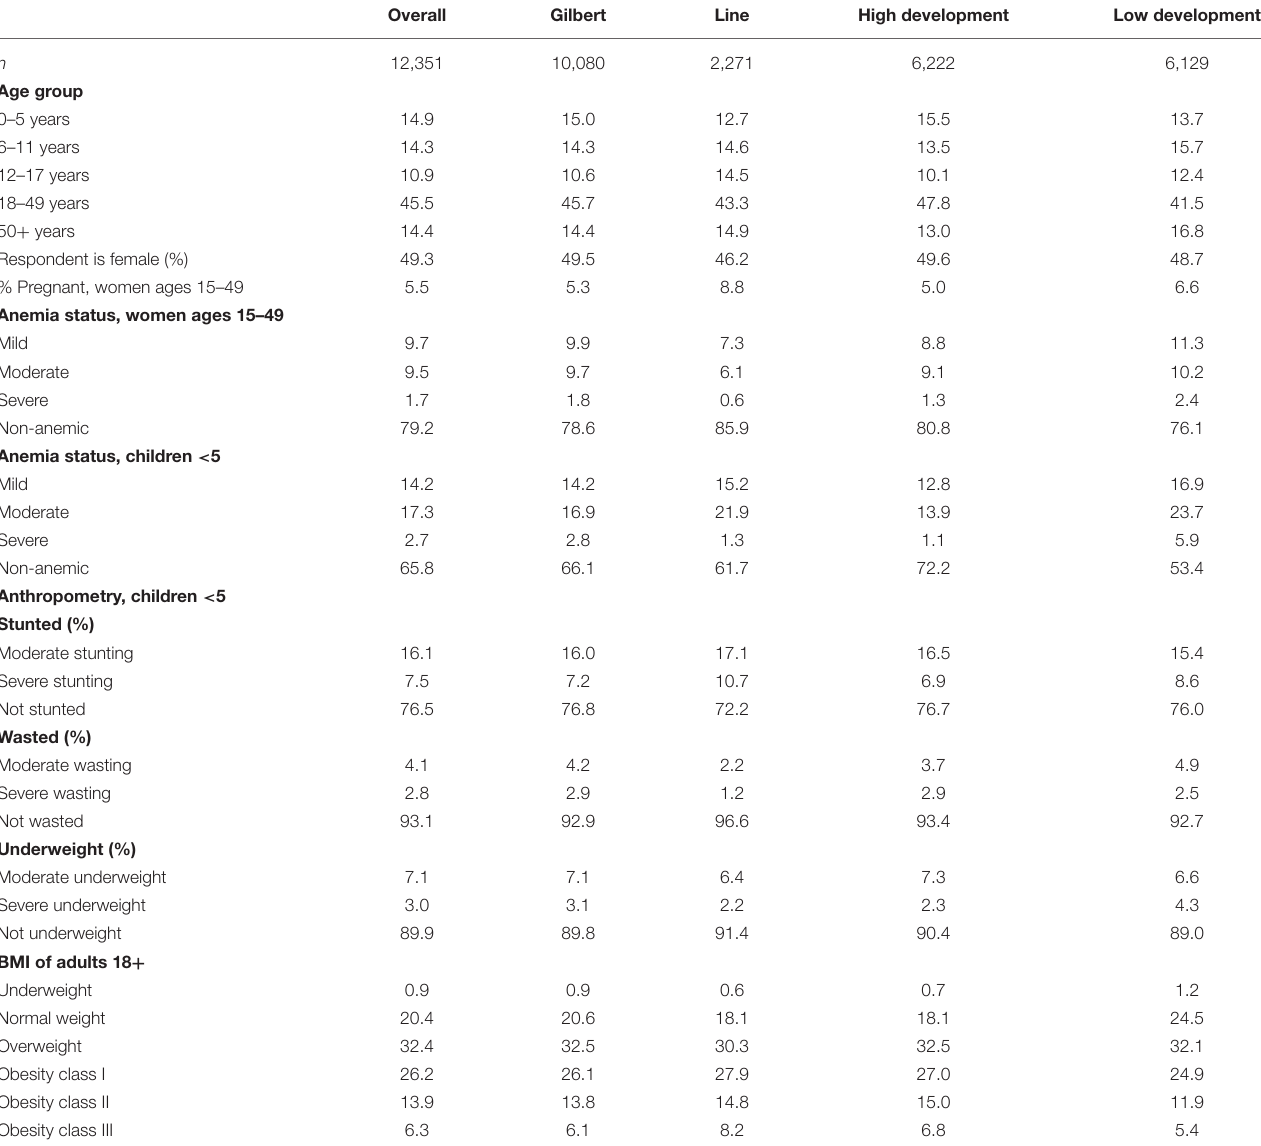
TABLE 3 | Demographic and disease status summary statistics of the enrolled HIES study population a . Overall Gilbert Line High development Low